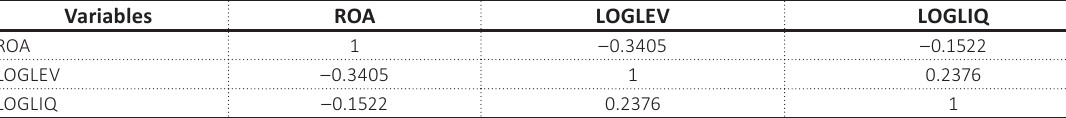
Table 3. Pearson’s correlation between variables